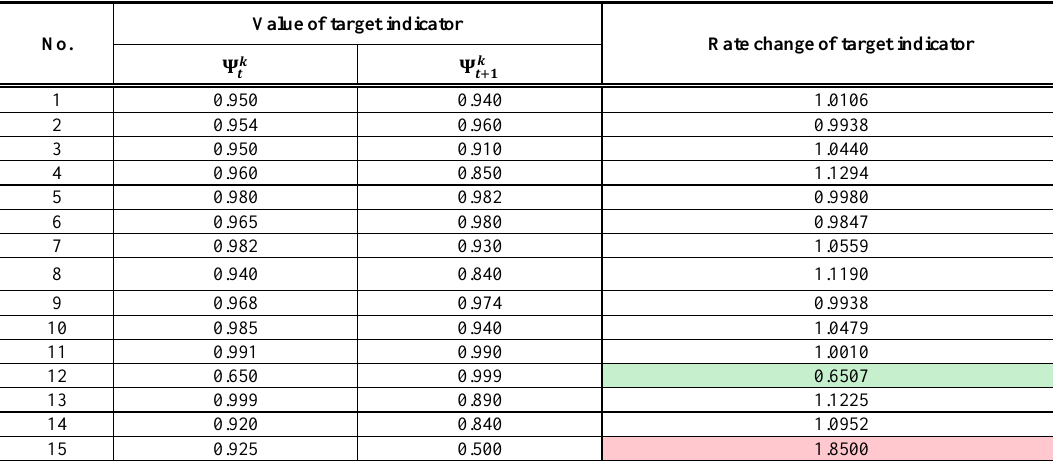
Table 1. Conditional values of indicator